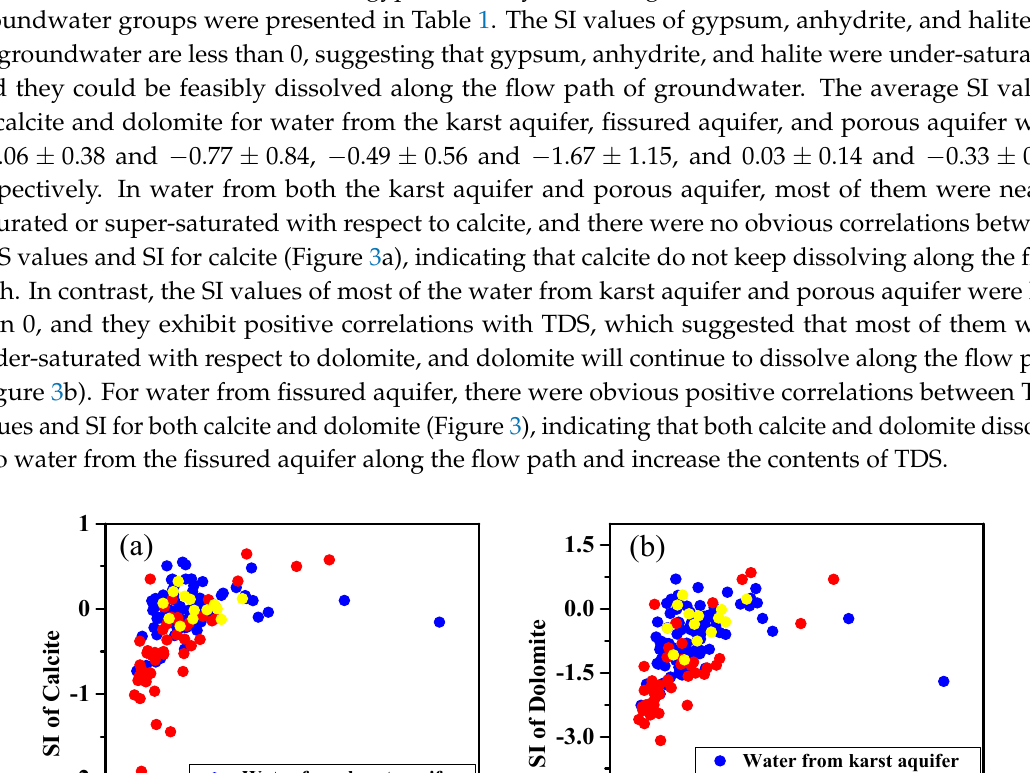
line in Figure 4: δ D = 8.59 δ 18 O + 17.7) [41], and far away from the Global Meteoric Water Line (GMWL) (solid line in Figure 4: δ D = 8 δ 18 O + 10) [42] (Figure 4). This indicated that groundwater in